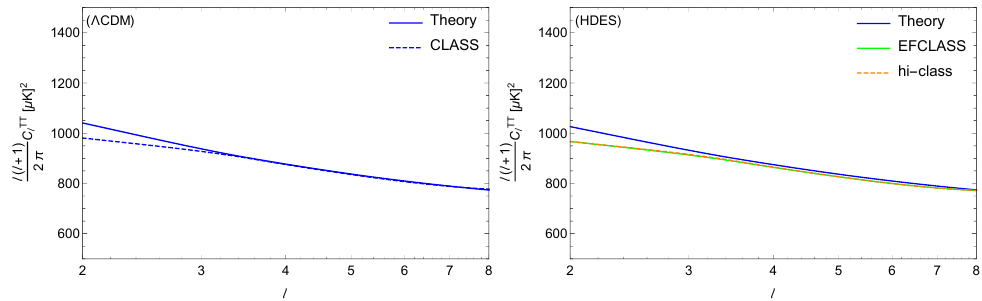
Figure 4. Plots of the ISW effect and a comparison with CLASS/hi_CLASS for the Λ CDM model ( left ) and the HDES model ( right ), for the same parameters as in Figure 3. Image from Ref.